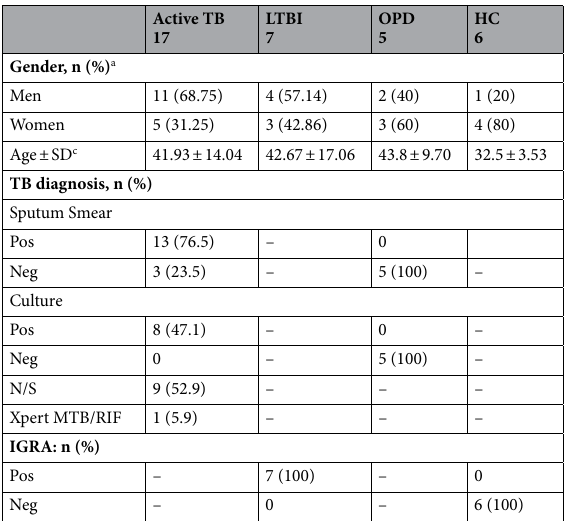
Table 1. Demographic and clinical data of study population. TB tuberculosis, LTBI latent tuberculosis infection, OPD other pulmonary disease, HC health communicants, SD standard deviation, N/S not screened. a Missing data: gender (TB = 1 and HC = 1) and age (TB = 1, TBL = 1 and HC =